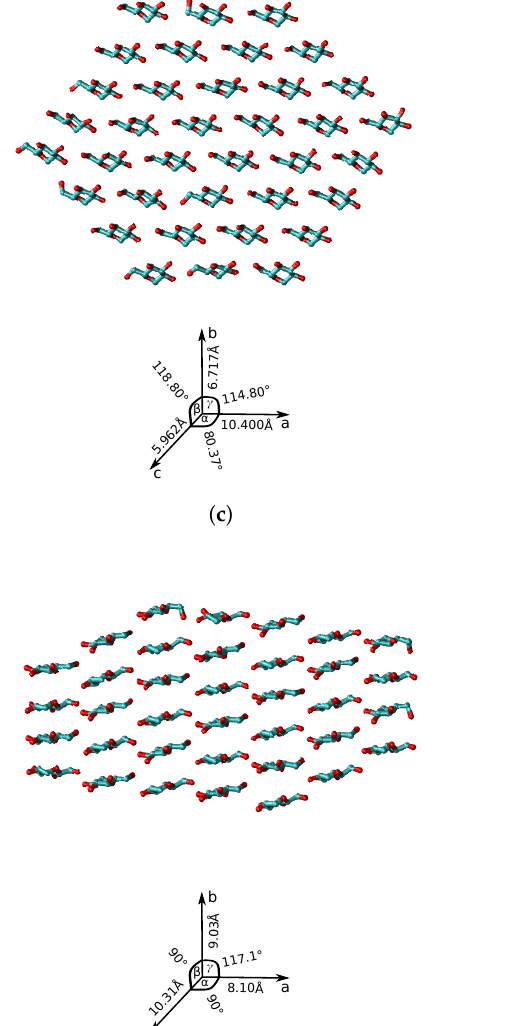
Figure 1. Snapshots of the cross-section for the relaxed atomistic structures of crystalline cellulose fibrils: ( a ) I α , ( b ) I β , and ( c ) type-II, and and crystallographic unit cells are shown on the right side, and the values are taken from Refs. [9,10,26]. D-glucose molecule is shown in licorice representation with oxygens atoms in red and carbon atoms in cyan colours. Hydrogens were not included in this representation for sake of clarity. The chemical structure of cellulose fibrils were build by Cellulose-builder toolkit and rendered by VMD